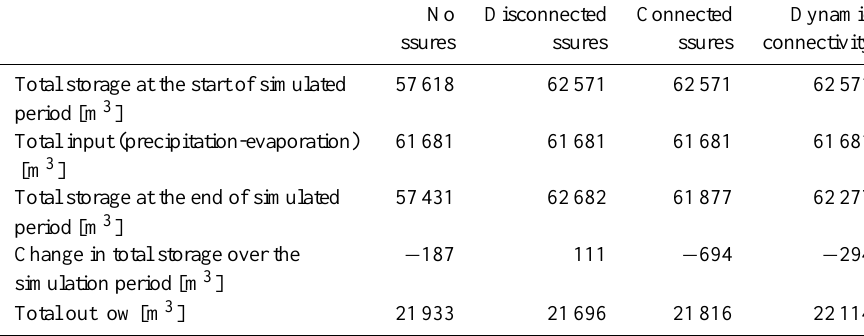
Table 1. Annual water balance components of four modelled scenarios, calculated for whole spatial domain.